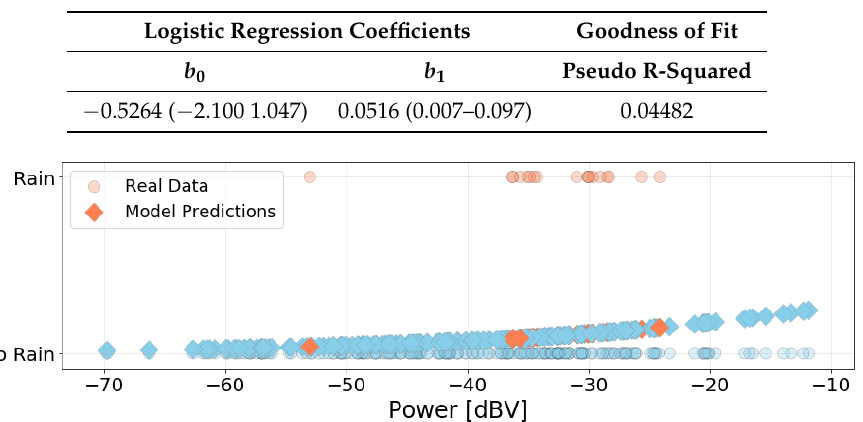
Table 6. Model coefficients (with confidence interval in parenthesis) and goodness of fit metrics for rain vs. power logistic model.